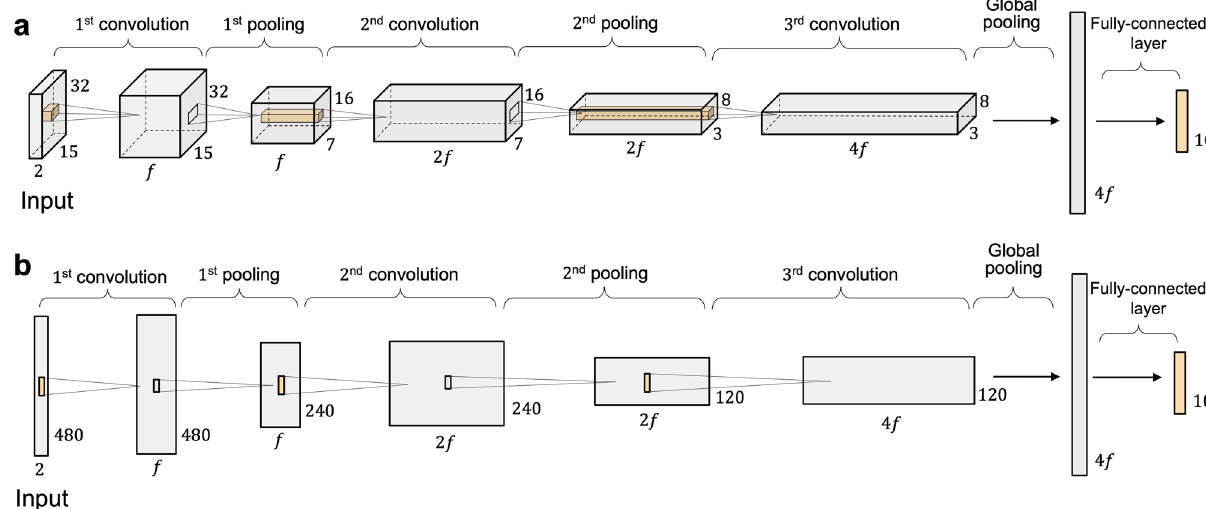
f ϵ {64,128} in the experiment. a The convolutional neural network with the 2D convolutions. b The convolutional neural network with the 1D